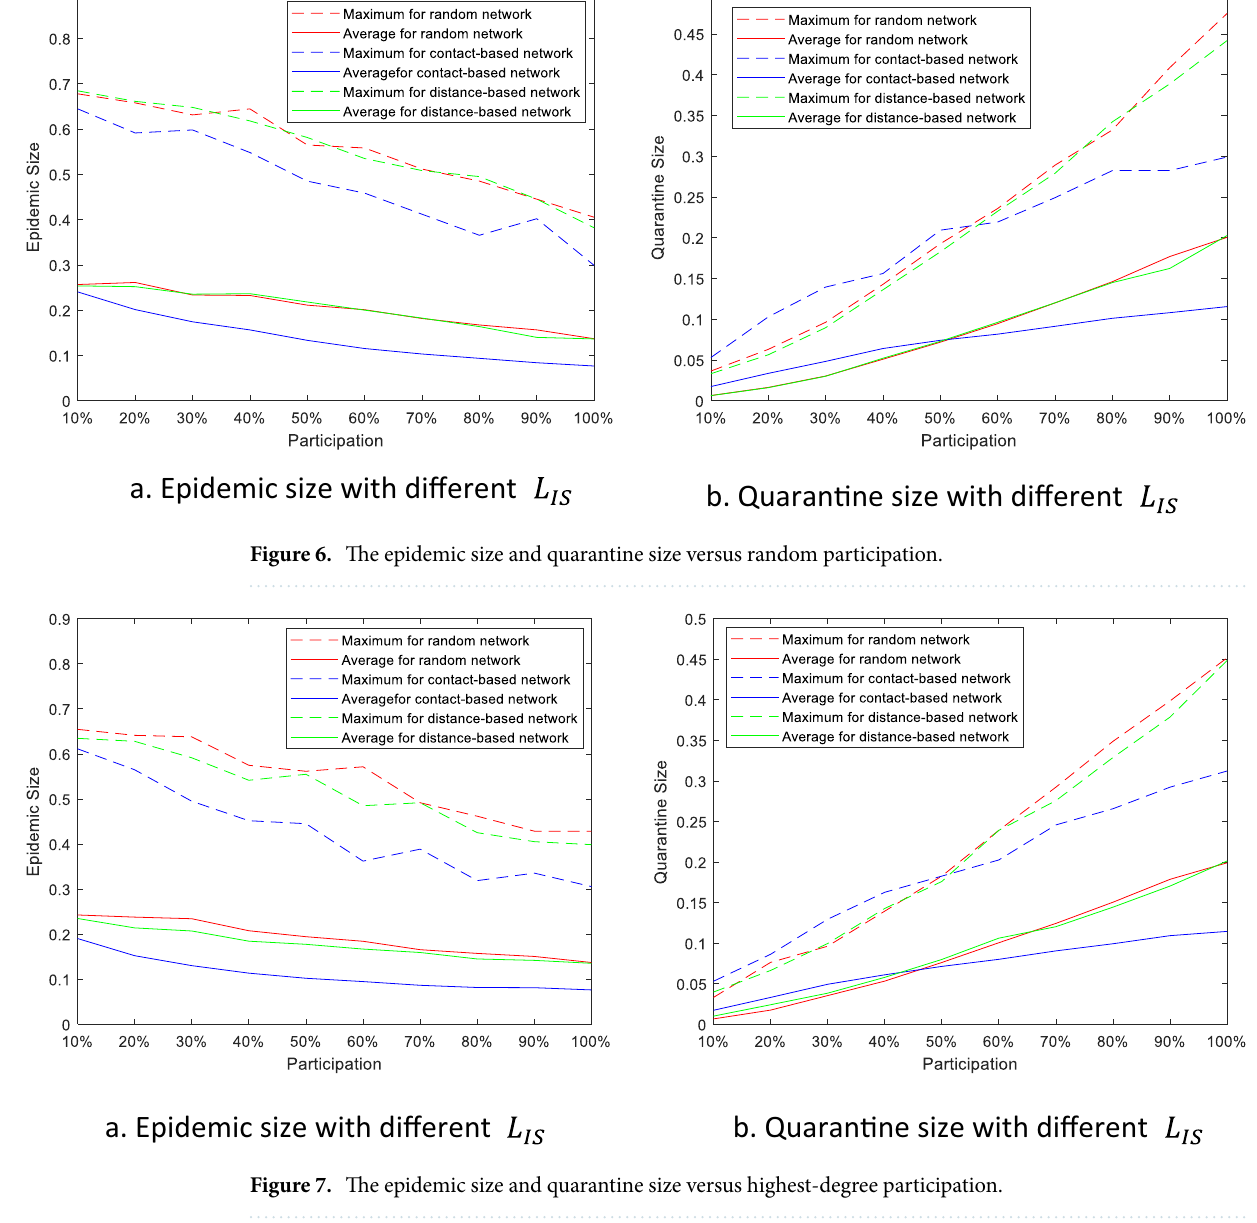
Figure 7. The epidemic size and quarantine size versus highest-degree